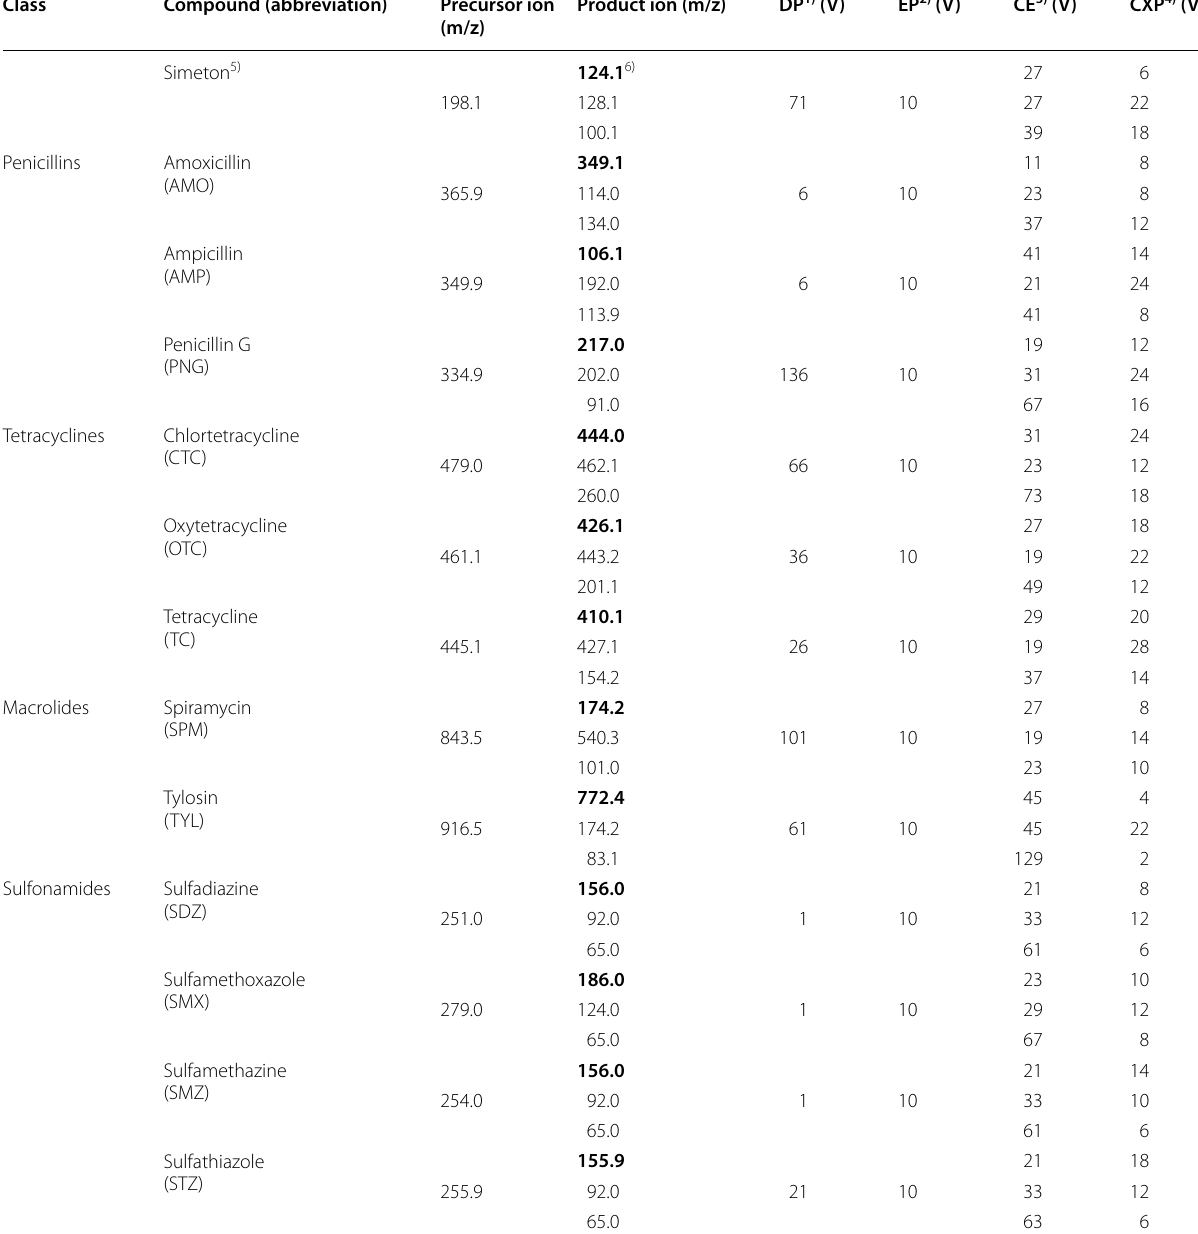
Table 1 LC–MS/MS parameters with MRM transitions for analysis of 12